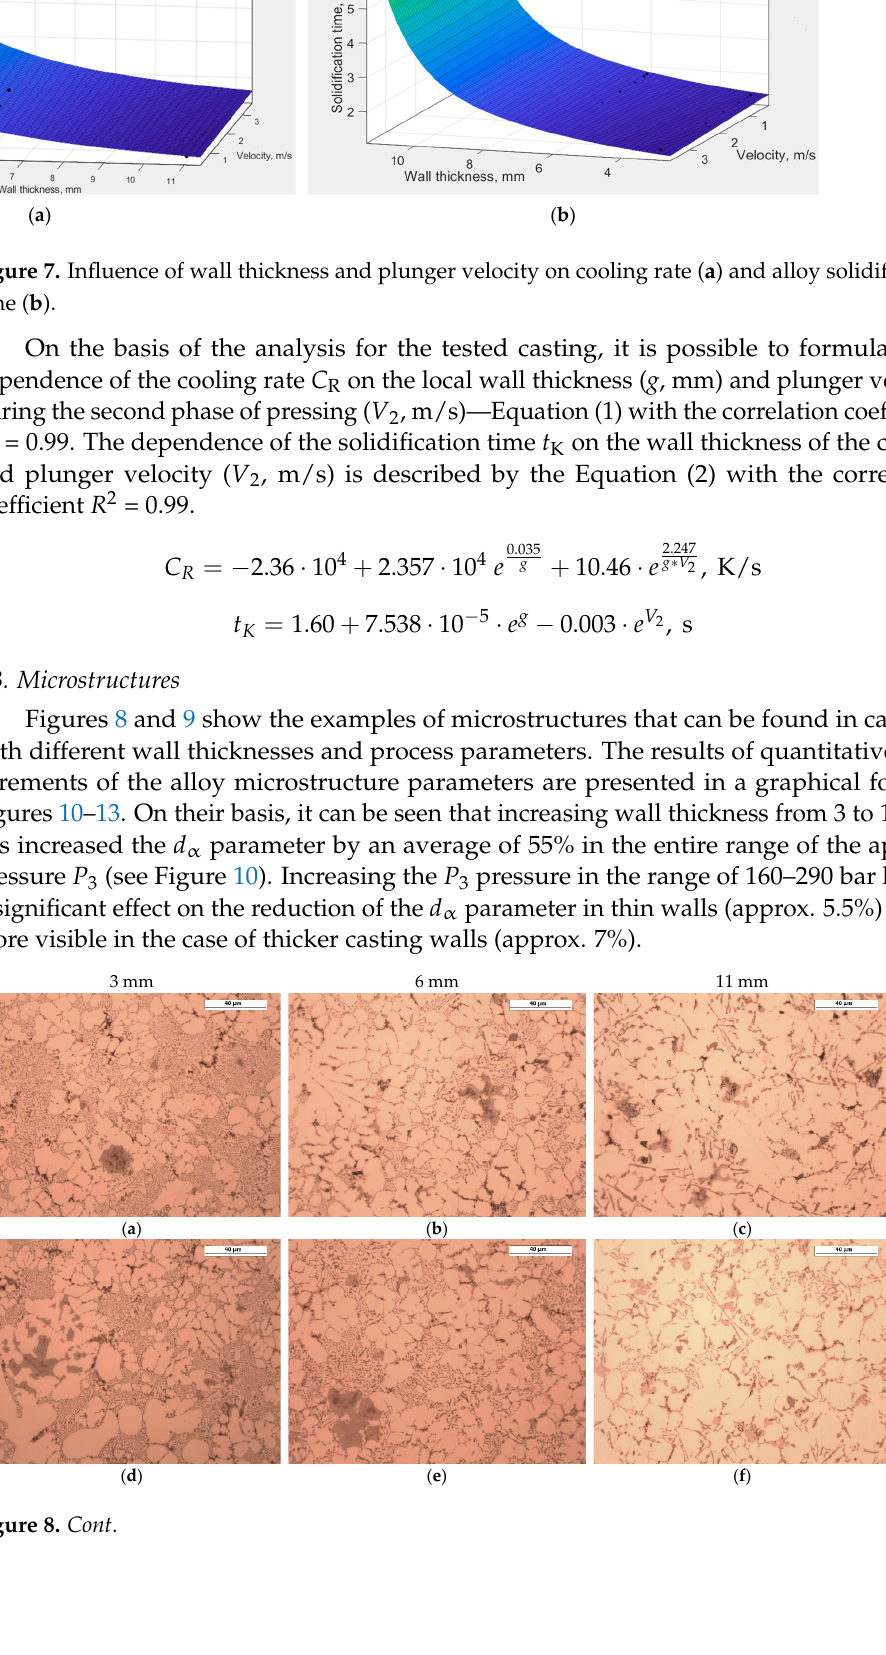
Figure 6. Simulated cooling curves and fraction solids in samples with different wall thicknesses (ProCAST).